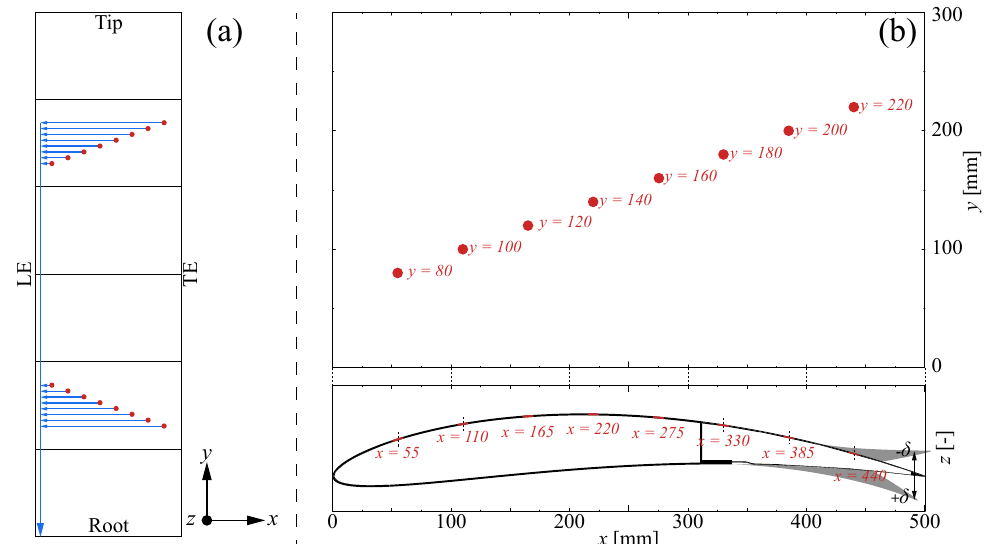
Figure 8. ( a ) Sensors locations (red circles) and wire paths (blue arrows) installed in the top skin of the SmartX wing. ( b ) Coordinates of sensors installed within a single section, including upper and lower morphing positions.